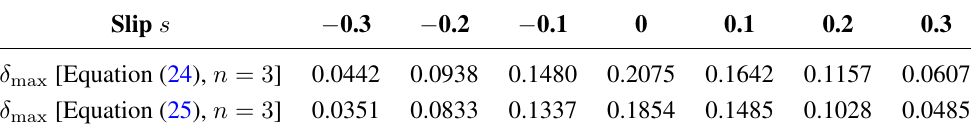
with different slips. max